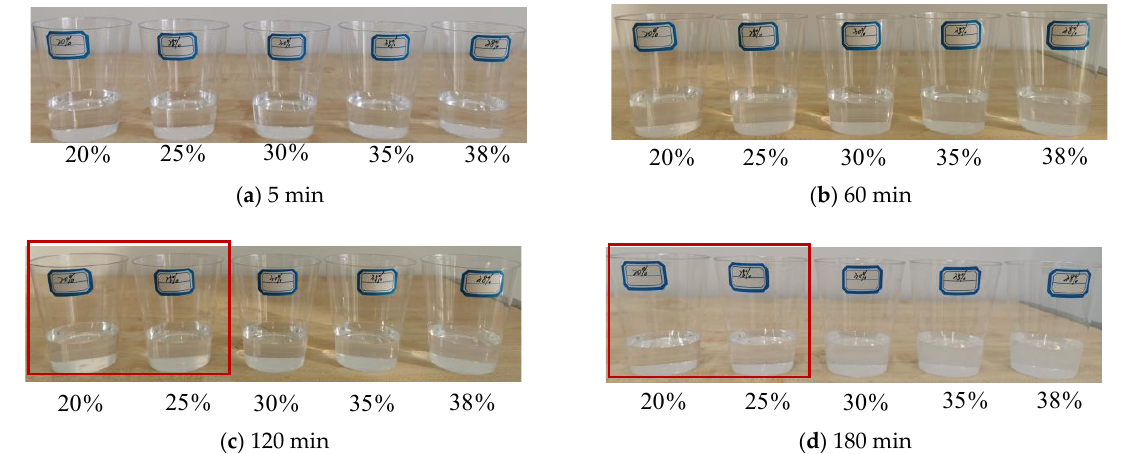
Figure 3. The effects of the concentration of sodium silicate on the stability of the precursor solutions of NS.